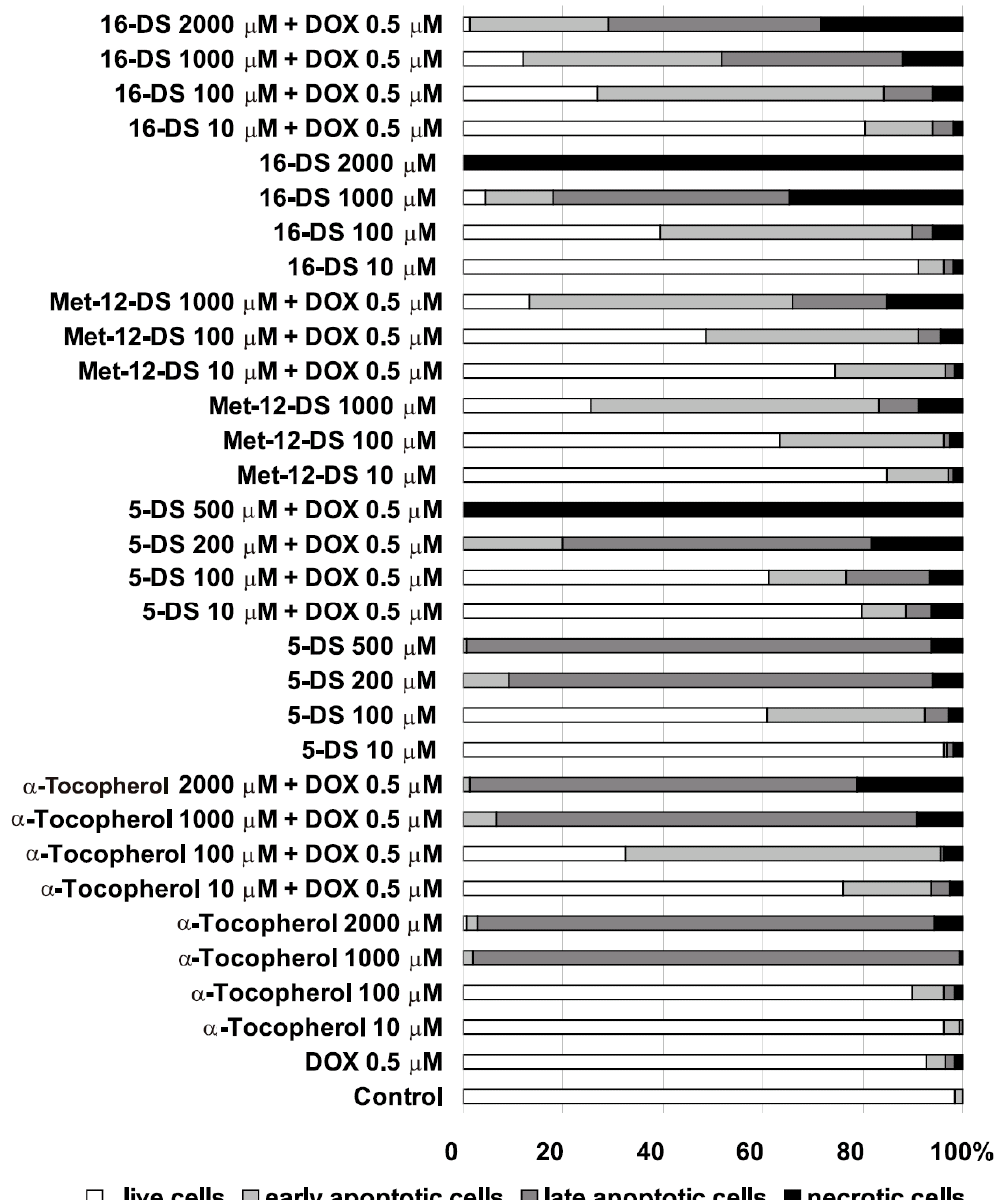
Figure 4. Percentages of live, early apoptotic, late apoptotic, and necrotic cells at 24 h after B14 cell treatment with α -Tocopherol; doxyl stearate nitroxides: 5-DS, Met-12-DS, and 16-DS, administered alone or in combination with 0.5 μ M doxorubicin (DOX). Changes in cell morphology associated with apoptosis/necrosis were determined based on fluorescent double staining with propidium iodide (PI) and Hoechst 33258 (Sections 2.2 and 4.2.3, Figure 3). The percentages of particular cell fractions were calculated in relation to all cells (100%).